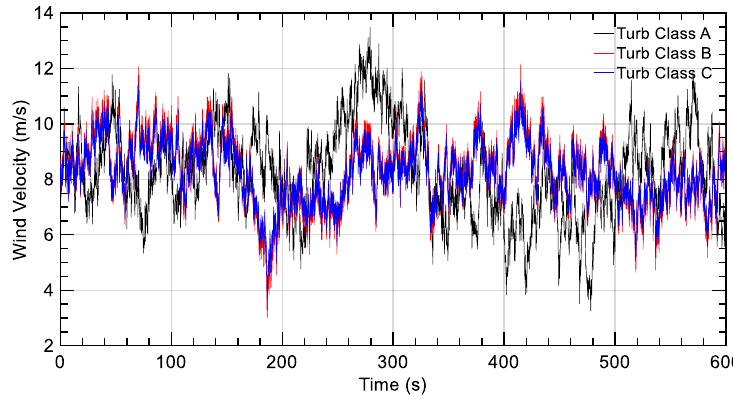
Figure 25. Wind Speed at Hub Height.